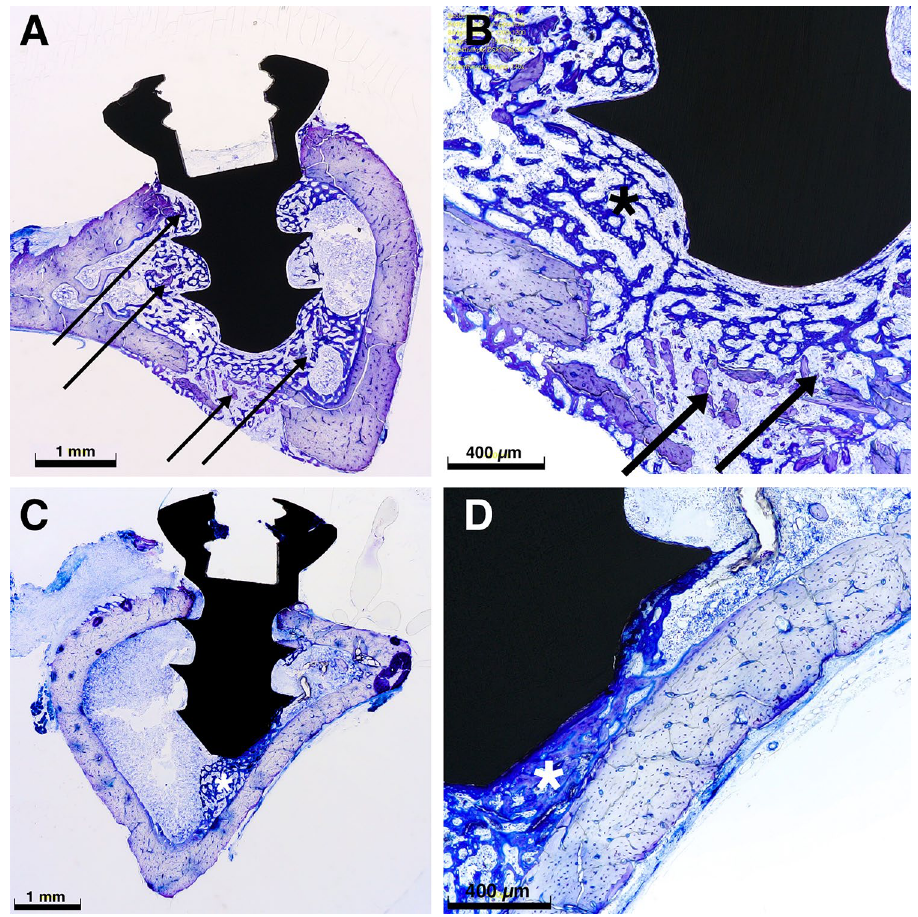
Figure 6. ( A ) Survey image of a test sample (50 °C, for a tempering time of 1 min, magnification of 42 ×) showing significant new bone formation adjacent to the implant (*) and necrosis at the implant shoulder (arrows), accentuated necrosis at the middle and the tip of the implant (arrows). ( B ) Close-up with a zoom of 140 ×, showing new bone formation (*) and evidence of necrosis (arrows) at the implant tip area. ( C ) Survey image of a control sample (no tempering, 42 ×) revealing mild to moderate new bone formation (*) predominantly adjacent to implant tip. No evidence of necrosis formation was measured. ( D ) Additionally, in the close-up of the control sample (140 ×), new bone formation without any evidence of necrosis was